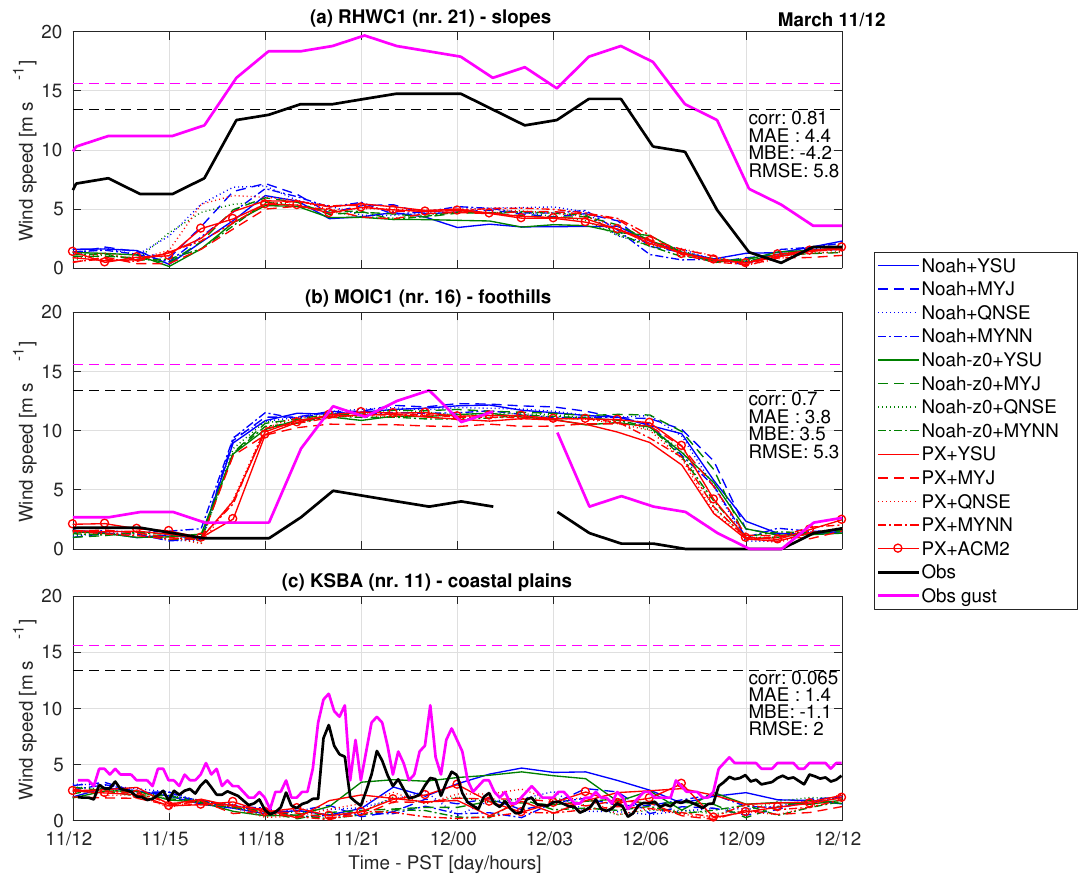
Figure 6. Observed and simulated wind speed at the ( a ) RHWC1, ( b ) MOIC1, and (c) KSBA stations (see Figure 1b for their location) in the lee of the SYM during the 11–12 March case study. The statistics in each panel represent physics-averages of all ensemble members. The black (sustained wind) and magenta (gust) dashed lines show the threshold for Sundowner